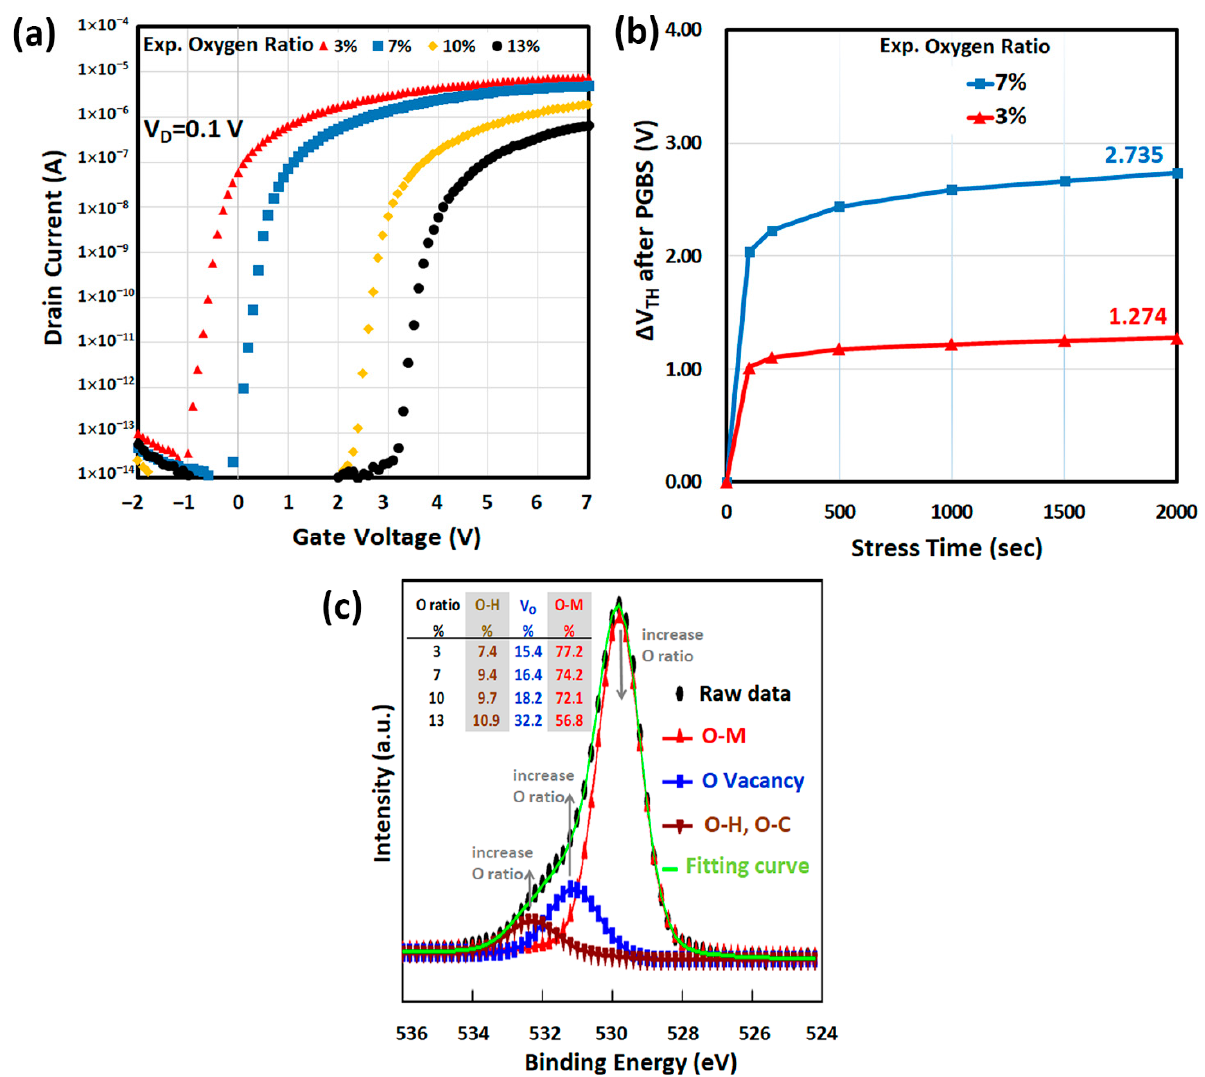
Figure 2. ( a ) The measured transfer characteristics of a-IWO TFT with different oxygen ratios of a-IWO. ( b ) The extracted positive V TH shift ( ∆ V TH ) dependence of stress time with different oxygen ratios of a-IWO after positive gate-bias stress (PGBS). ( c ) XPS fitting of O 1s with different oxygen ratios of a-IWO.